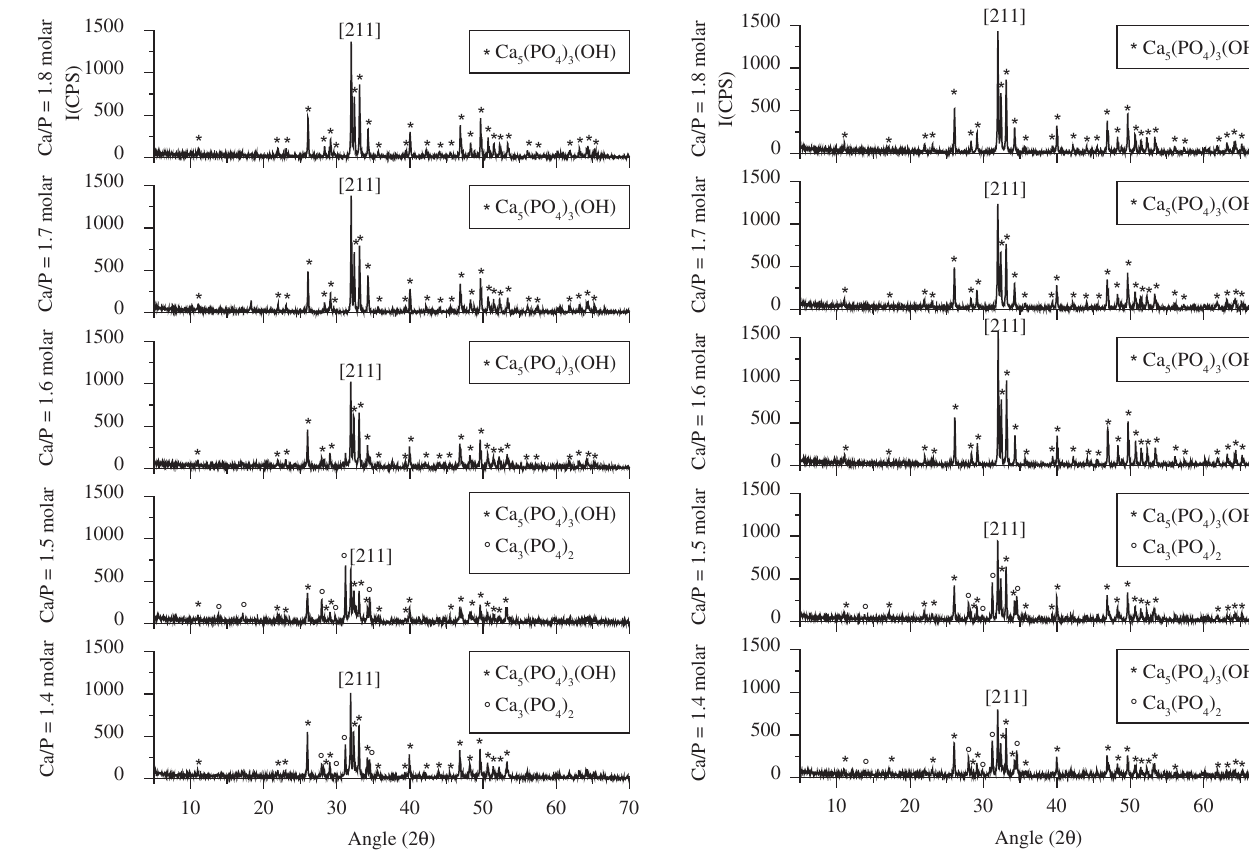
Figure 9. Spectra of X ray diffractometry on specimens which had been hydrated for one day for the different compositions (peaks per second as a function of 2 θ ).